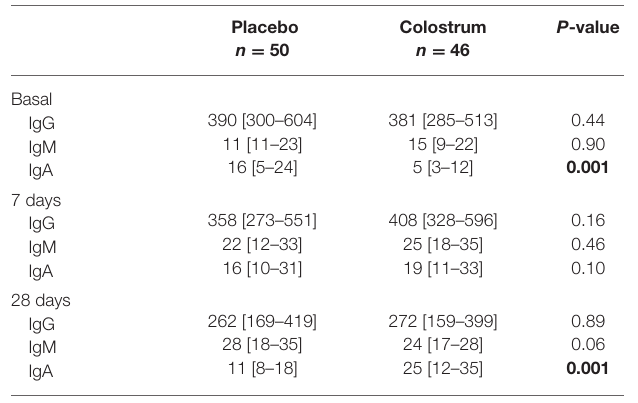
TABLE 3 | Immunoglobulins between groups.